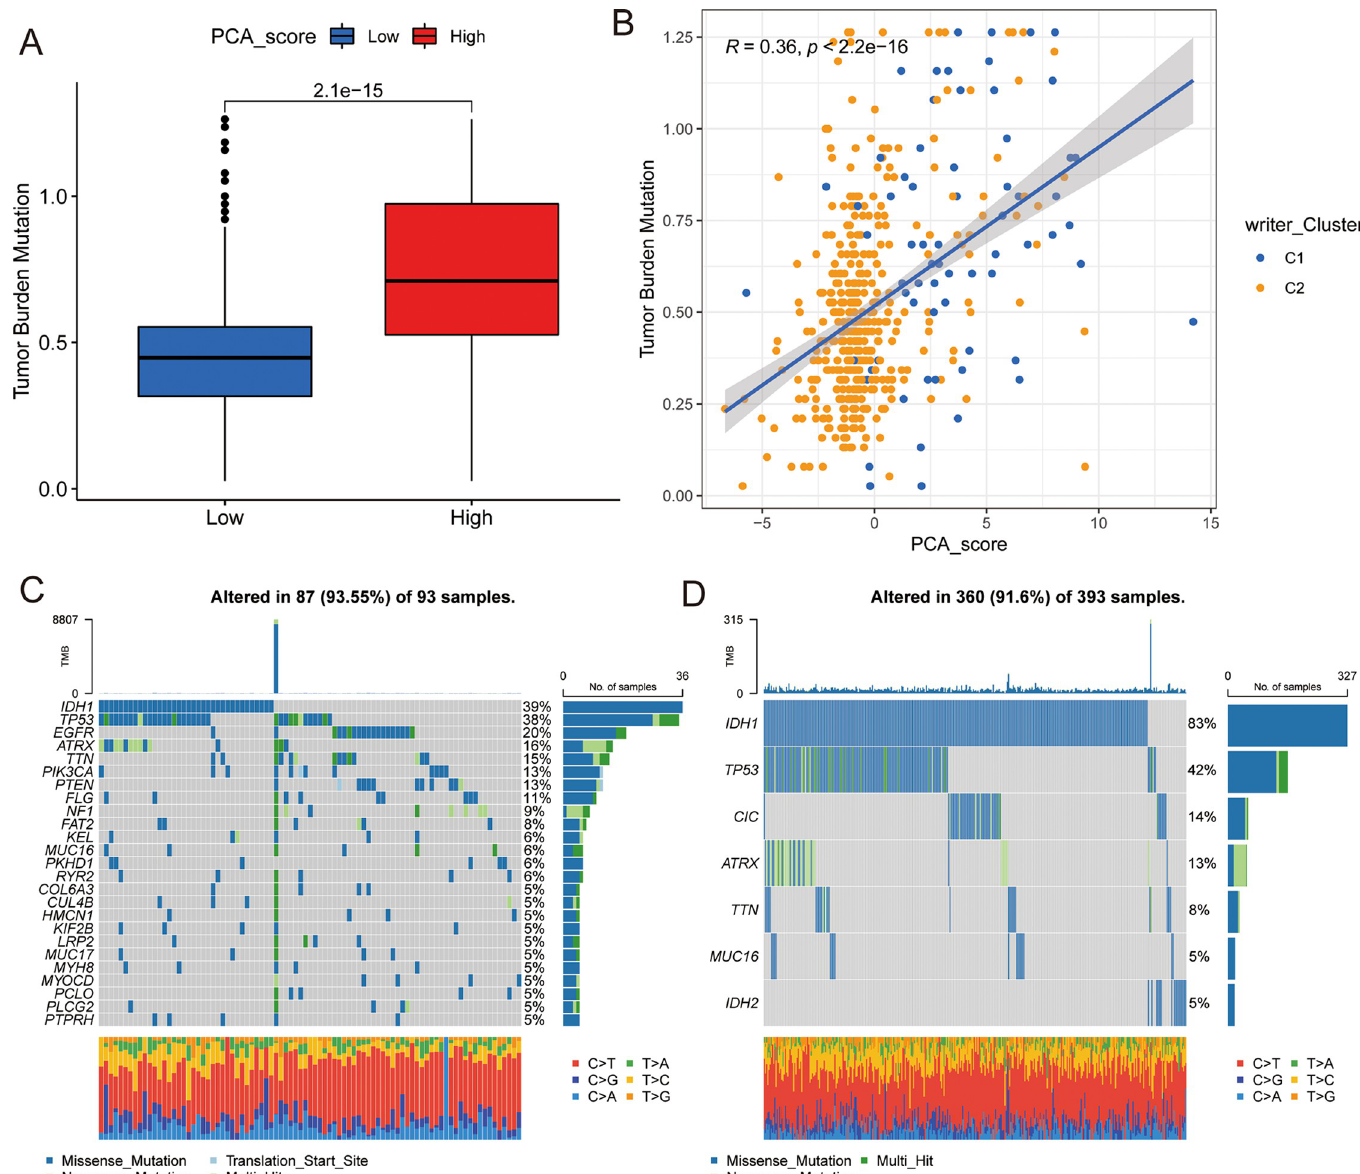
Fig 7. Correlation analysis of PCA_score and TCGA-LGG cohort somatic mutations. (A) TMB in different PCA_score groups. (B) pearson correlation analysis of the PCA_score and TMB. (C and D) The waterfall plot of somatic mutation features established with high and low PCA_scores. Each column represented an individual patient. The upper barplot showed TMB, the number on the right indicated the mutation frequency in each gene. The right barplot showed the proportion of each variant type.